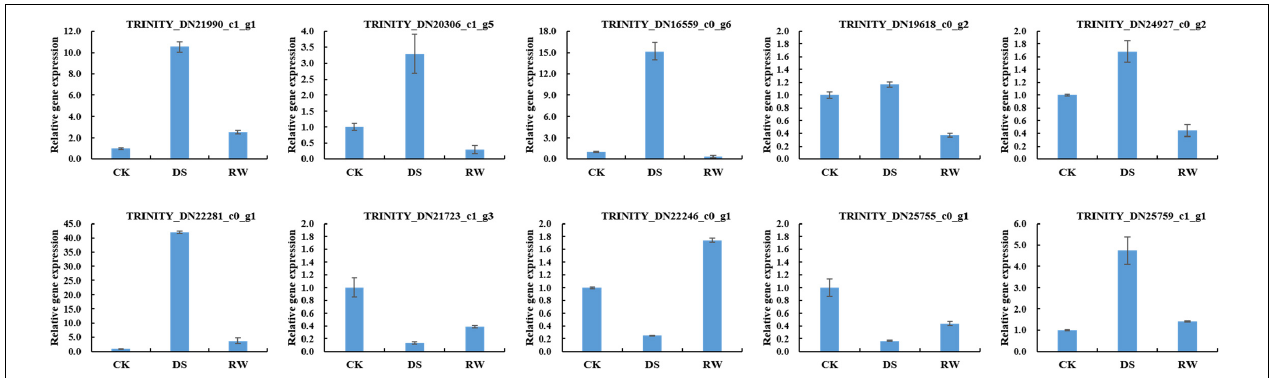
FIGURE 2 | Relative gene expression for qRT-PCR verification of mRNA-Seq results. The data were the average of three qRT-PCR replicates for each sample from three biological replicates. GAPDH of alfalfa was used as an internal reference. Error bars indicate the standard deviation of three biological replicates.